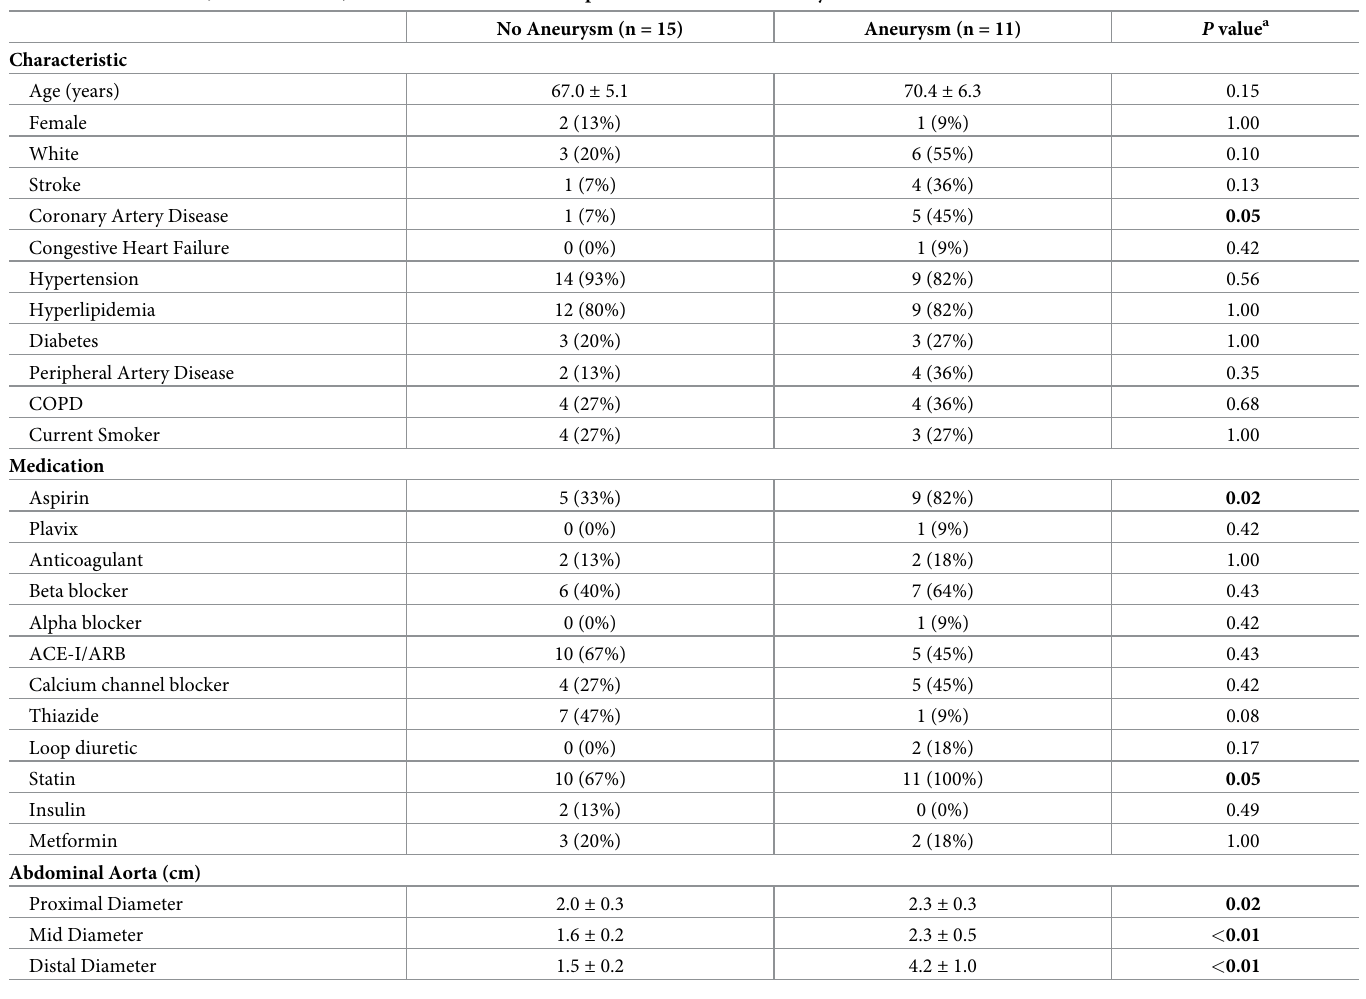
Table 3. Characteristics, medication use, and abdominal aorta size of patients enrolled in the study.